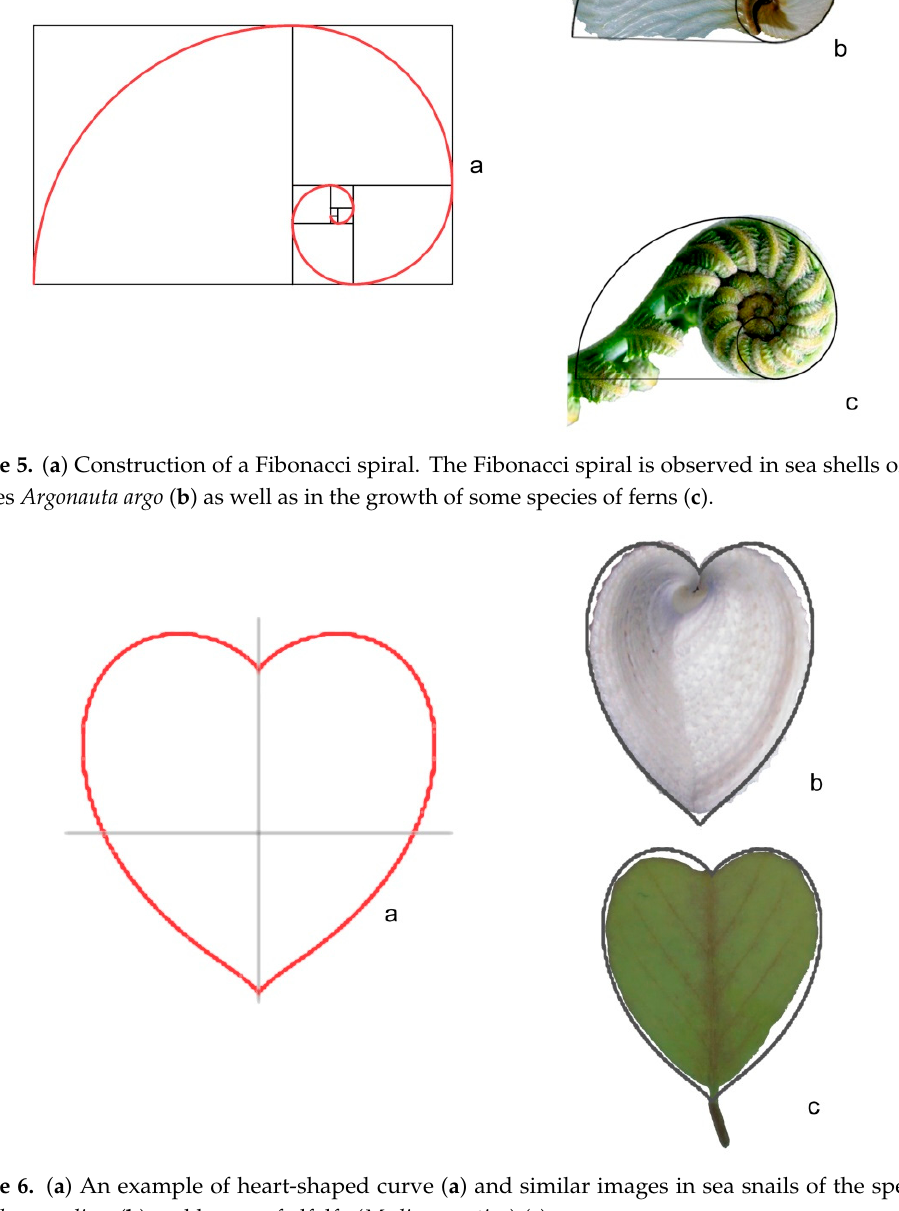
Figure 6. ( a ) An example of heart-shaped curve ( a ) and similar images in sea snails of the species Corculum cardissa ( b ) and leaves of alfalfa ( Medicago sativa ) ( c Corculum cardissa ( b ) and leaves of alfalfa ( Medicago sativa ) ( c ).